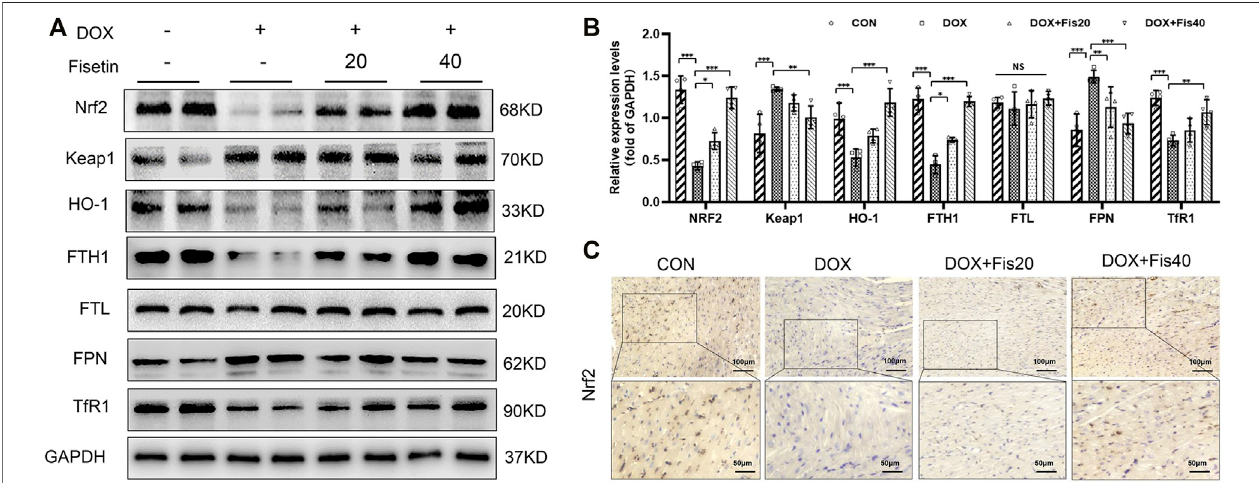
FIGURE 4 | Fisetin protects against DOX-induced ferroptosis via regulating Nrf2 in rats. (A) . Western blot results of Nrf2 and Keap1, HO-1, FTH1, FTL, FPN, and TfR1 protein in control and different drug-treated rat heart tissues. (B) . Quanti fi cation of (A) . (C) . Expression of Nrf2 was detected by immunohistochemistry (IHC) (Representativeimages,200Xand400X,Scalebar=100and50 μ m, n =6ratspergroups)incardiactissueofeachgroup.Thevaluesarepresentedasmean±SD.* p < 0.05;** p < 0.01;*** p < 0.001;NS,nosigni fi cance;DOX,doxorubicin.Nrf2,nuclearfactorerythroid2-relatedfactor2;Keap1,Kelch-likeECH-associatedprotein1;